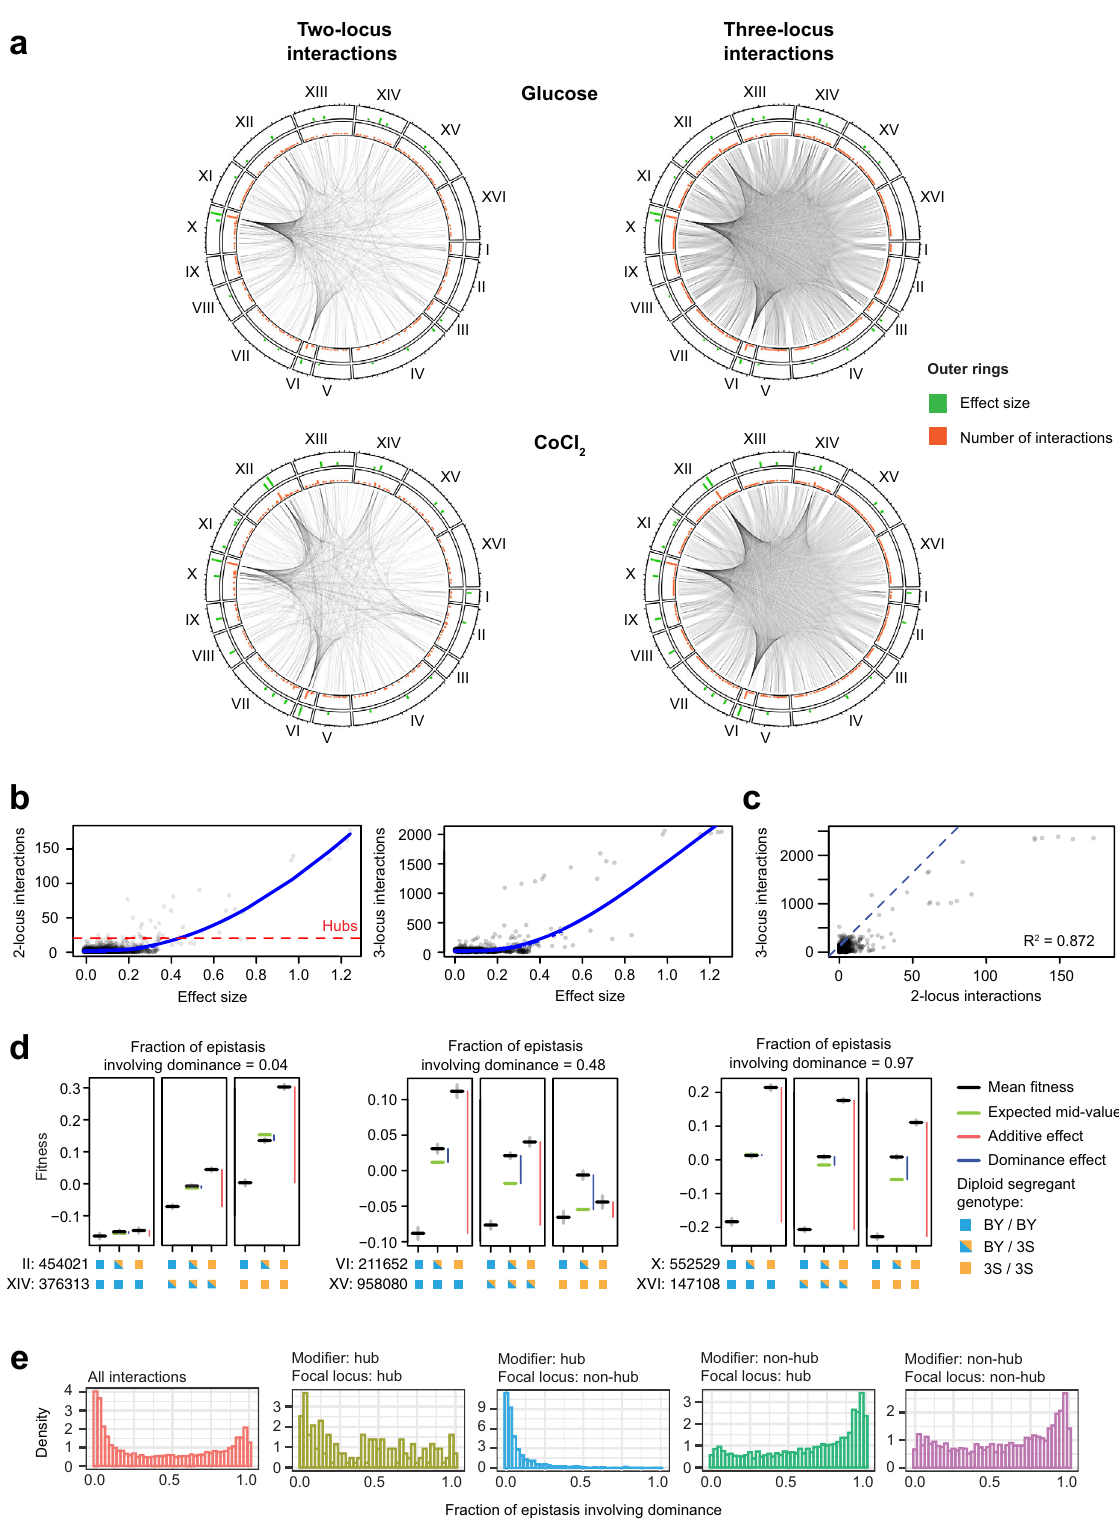
growing the cells on YPD + 5-FOA plates. The BY MAT a and MAT α cross parents were preserved at − 80 °C with the unique identi fi ers IEY1176 and IEY1177, respectively. The 3S MAT a and MAT α cross parents were preserved at − 80 °C with the unique identi fi ers IEY1178 and IEY1179, respectively. To prevent aggregation of cells in pools grown in liquid, FLO8 , a transcriptional activator of many fl occulins 49 , and FLO11 , the fl occulin responsible for many aggregation phenotypes in S. cerevisiae 50 , were fi rst knocked out in both mating